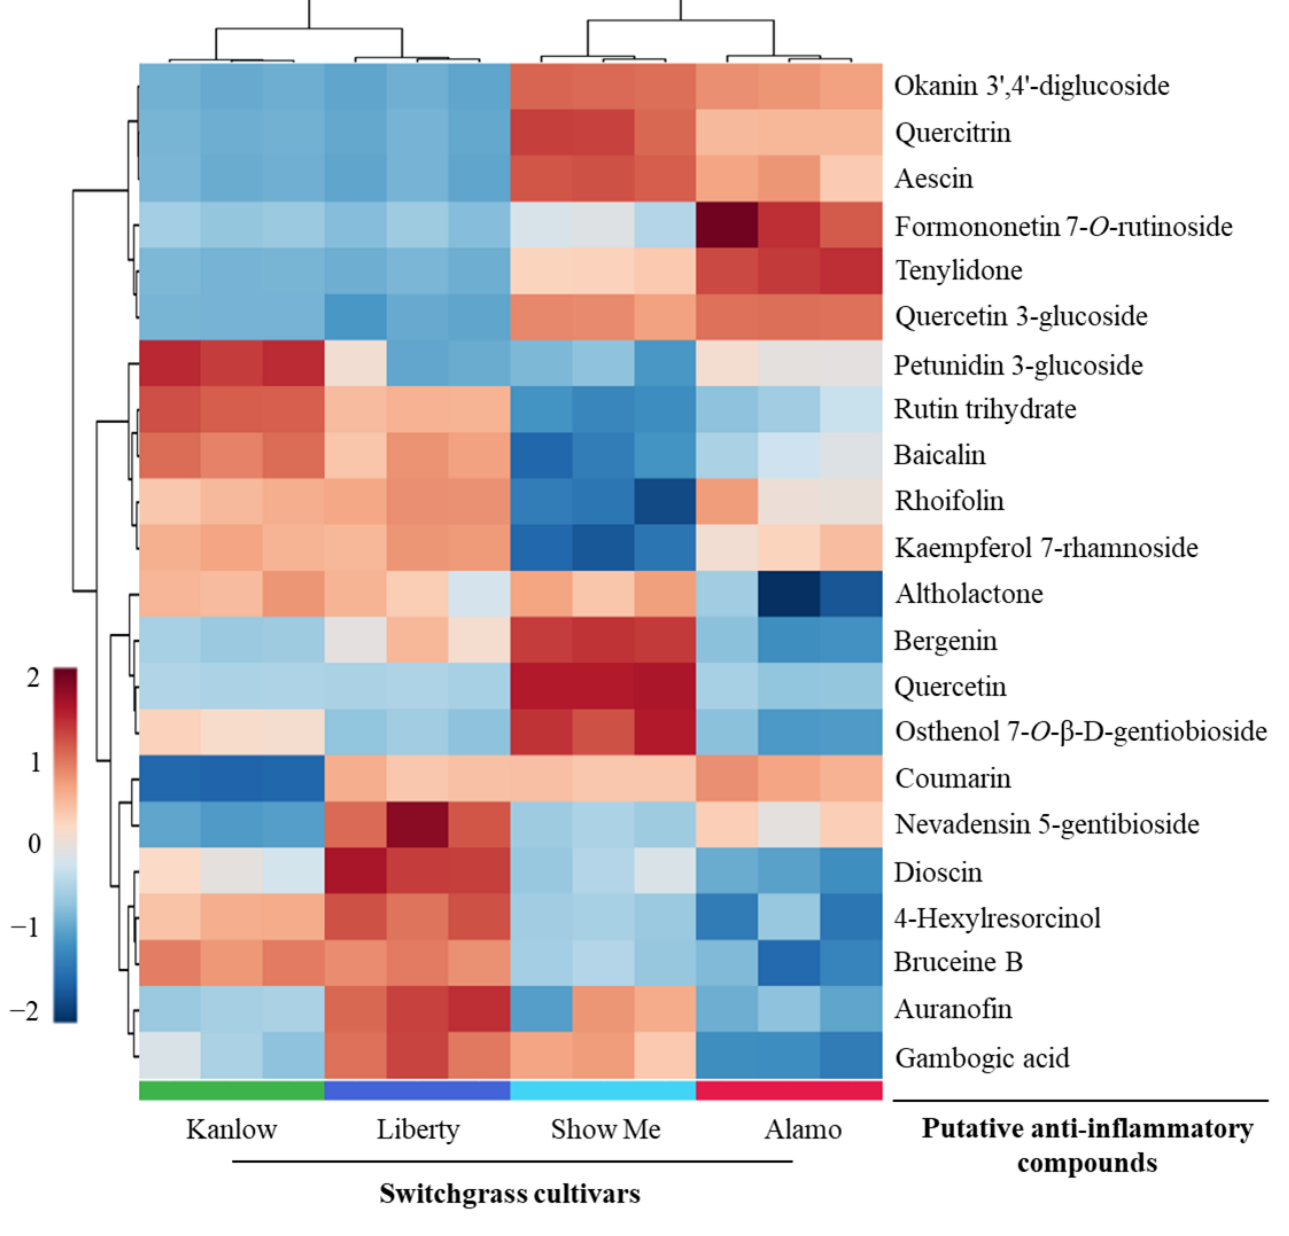
Figure 5. Relative concentrations of anti-inflammatory metabolites in switchgrass. Red indicates higher relative concentrations, whereas blue indicates lower relative concentrations. Table 3. Amounts of anti-inflammatory compounds (mg/kg) in switchgrass determined by UPLC- MS/MS.